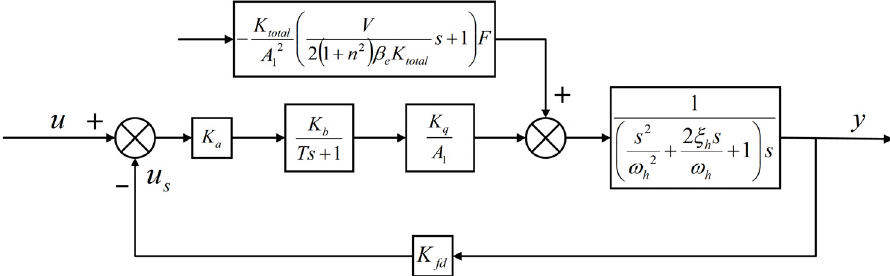
Figure 6. Block diagram of the valve-controlled